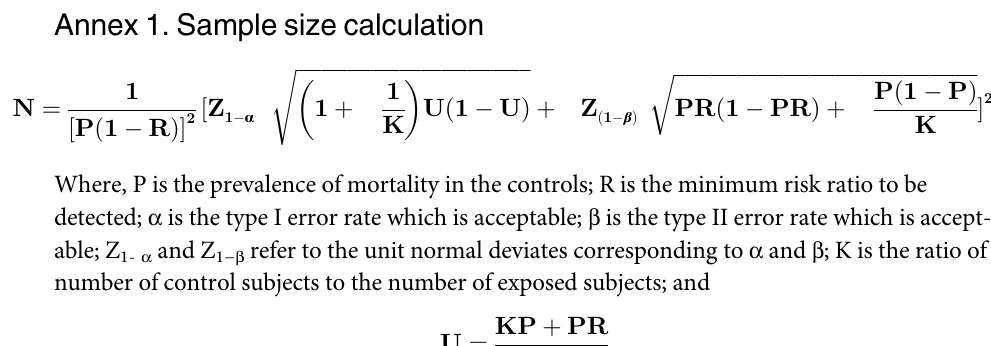
S1 Table. Characteristics of HIV-infected patients on IPT plus ART or ART alone survived or died during the study period, Addis Ababa,